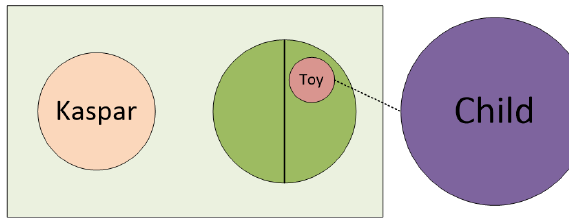
Figure 5: Equipment layout diagram for game 7.